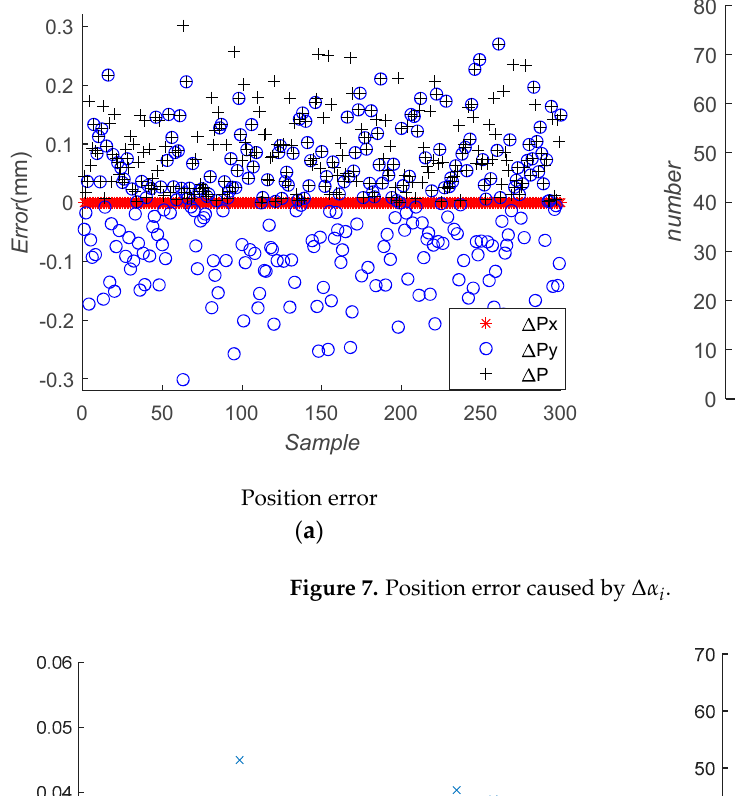
Figure 7. Position error caused by Δ α i .